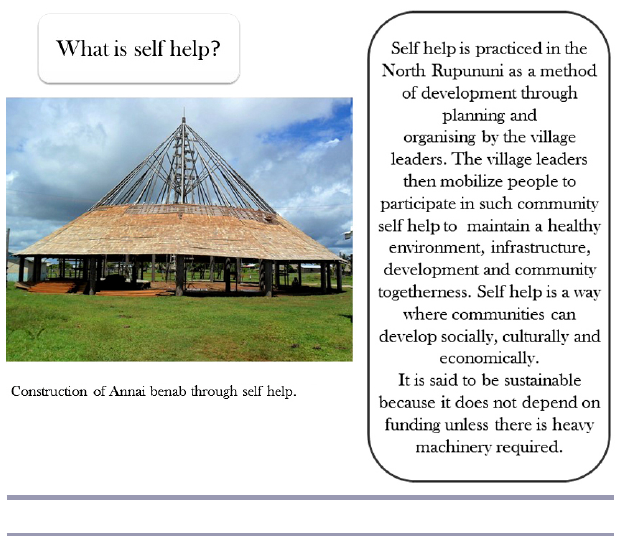
Fig. 6 . Champions of the resistance best practice.